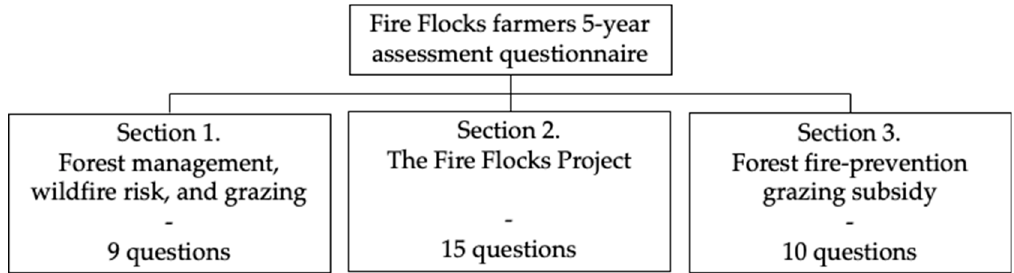
Figure 3. Overview of the Fire Flocks 5-year assessment questionnaire.